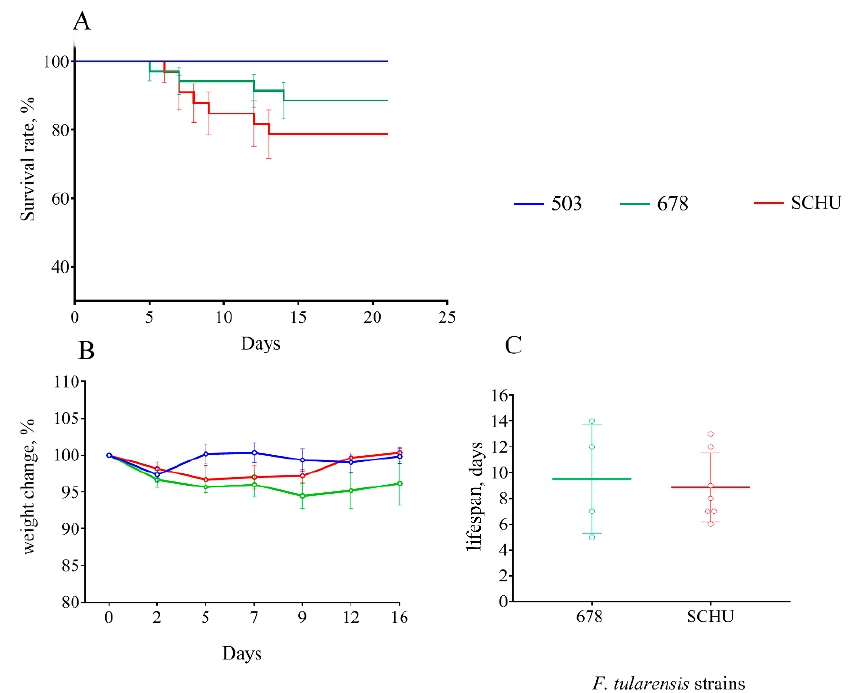
Figure 1. Survival rate ( A ) and bodyweight changes ( B ) of mice immunized 30 days before infection with virulent strains of F. tularensis : subsp. holarctica 503, subsp. mediasiatica 678, and subsp. tularensis SCHU. Values are indicated with the standard error of the mean (SEM) for each measurement point.